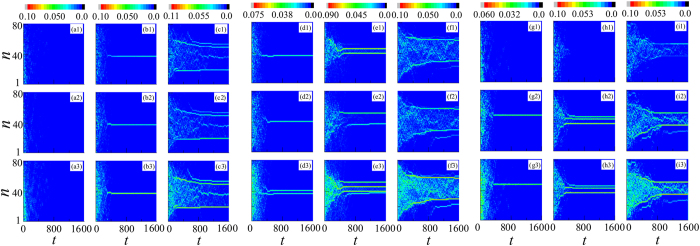
Formation of DBs of two-species BECs in open optical lattices with M = 81 sites.The color code shows |ψ1,n|2 (normalized to 1 at t = 0 for species 1), |ψ2,n|2 (normalized to 1 at t = 0 for species 2), and |ψ1,n|2 + |ψ2,n|2 in the first, the second, and the third rows, respectively. The initial condition is a homogeneously populated lattice with random phases at each site randomly drawn from [0, 2π]. The boundary dissipation rates at sites 1 and M are γ1 = γ2 = 0.3. The other parameters are chosen as follows: Λ1,2 = 0.1 < Λb for (a1–a3), (d1–d3), and (g1–g3); Λ1,2 = 0.5 > Λb for (b1–b3), (e1–e3), and (h1–h3), and Λ1,2 = 1 > Λb for (c1–c3), (f1–f3), and (i1–i3). (a–c) Λ1,1 = Λ2,2 = 0.1; (d–f) Λ1,1 = Λ2,2 = 0.6; (g–i) Λ1,1 = 0.1 and Λ2,2 = 0.6.